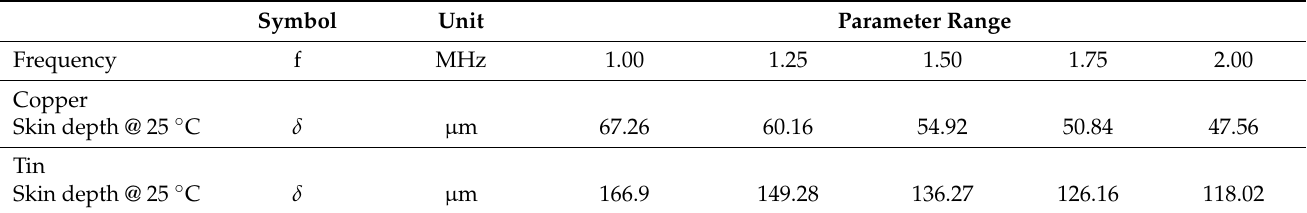
Table 1. Dependence of the skin depth on the EM field frequency.